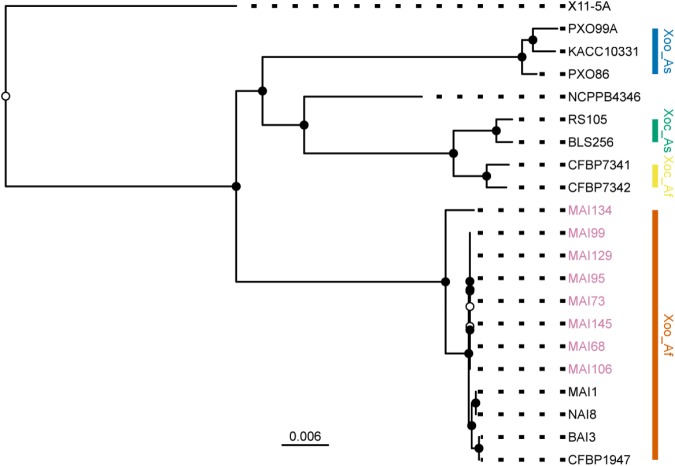
Position of the sequenced Malian Xoo strains in the X. oryzae phylogeny. Plot of the RAxML tree obtained from a core genome SNPs alignment composed of the PacBio sequenced Malian strain haplotypes (pink strain labels) and reference strains representative of major genetic groups in the X. oryzae phylogeny. The X. oryzae X11-5A strain served as an outgroup for rooting the tree. The main clades are highlighted with a colored vertical bar. Abbreviations for the label of the clades are as follows: Xoo, X. oryzae pv. oryzae; Xoc, X. oryzae pv. oryzicola; As, Asia; Af, Africa. Internal nodes were colored in black when bootstrap support values were above 80. The scale bar at the bottom of the tree reflects branch length in mean number of nucleotide substitutions per site.